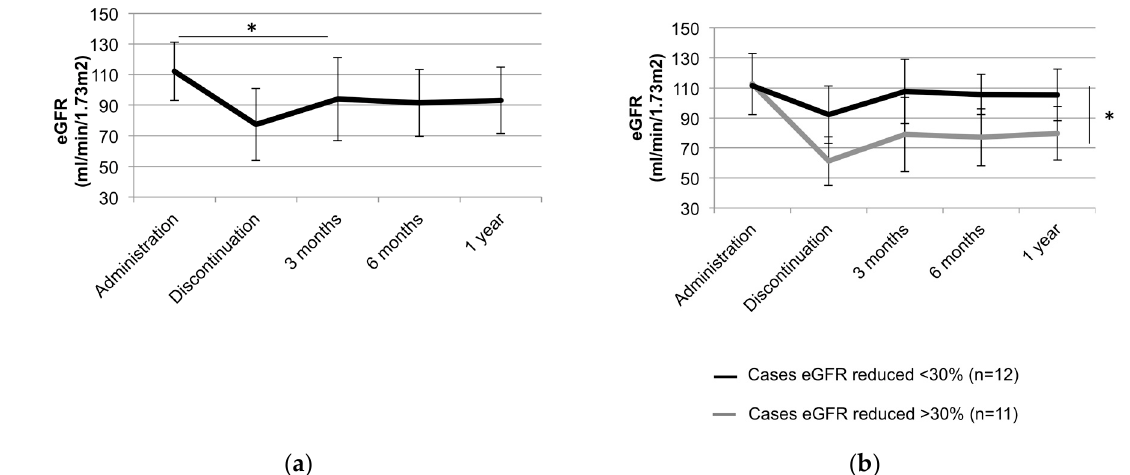
Figure 6. Changes in estimated glomerular filtration rate (eGFR) after tacrolimus (TAC) discontinuation. ( a ) Changes in eGFR in overall patient population. Changes in renal function were analyzed in 23 patients treated with TAC for more than 6 months and whose course could be followed for more than 1 year after discontinuation of TAC treatment. * p < 0.05 (analyzed using Mann–Whitney test). ( b ) Changes in eGFR in patients with eGFR reductions less than 30% (n = 12) and in patients with eGFR reductions more than 30% (n = 11) after administration. * p < 0.05 (analyzed using Mann–Whitney’s test).